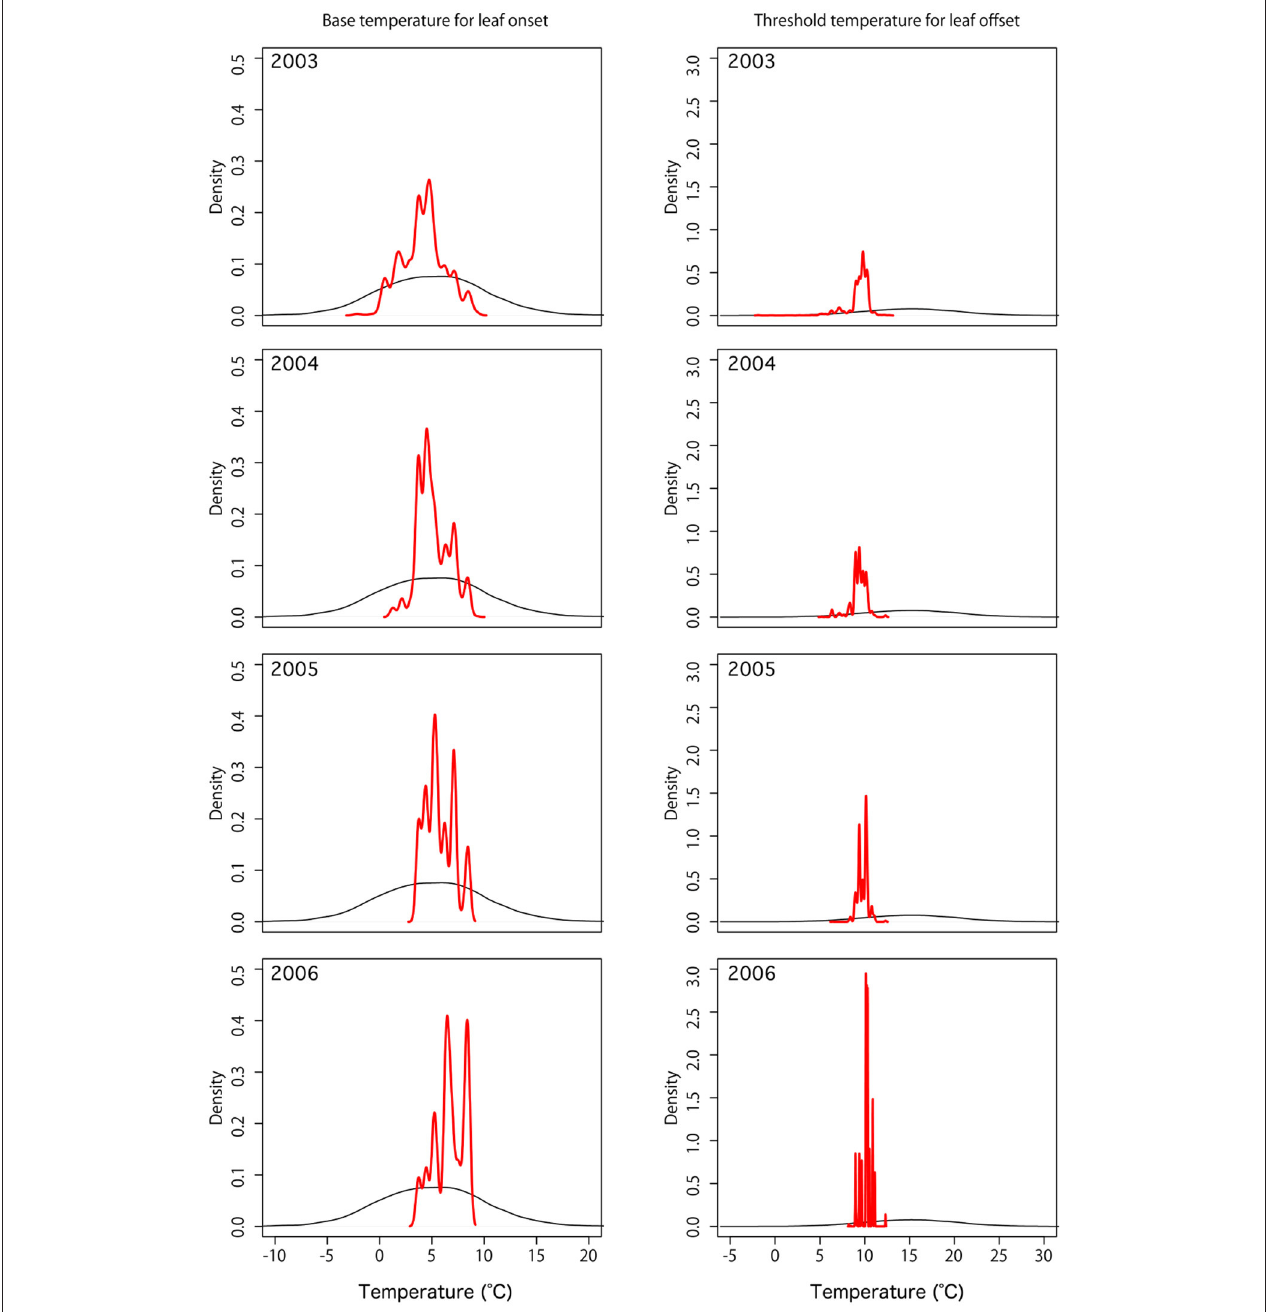
FIGURE 3 | Probability distribution of default (black) and optimized (red) phenology parameters: base temperature for leaf onset (T onset ) and threshold temperature for leaf offset (T offset